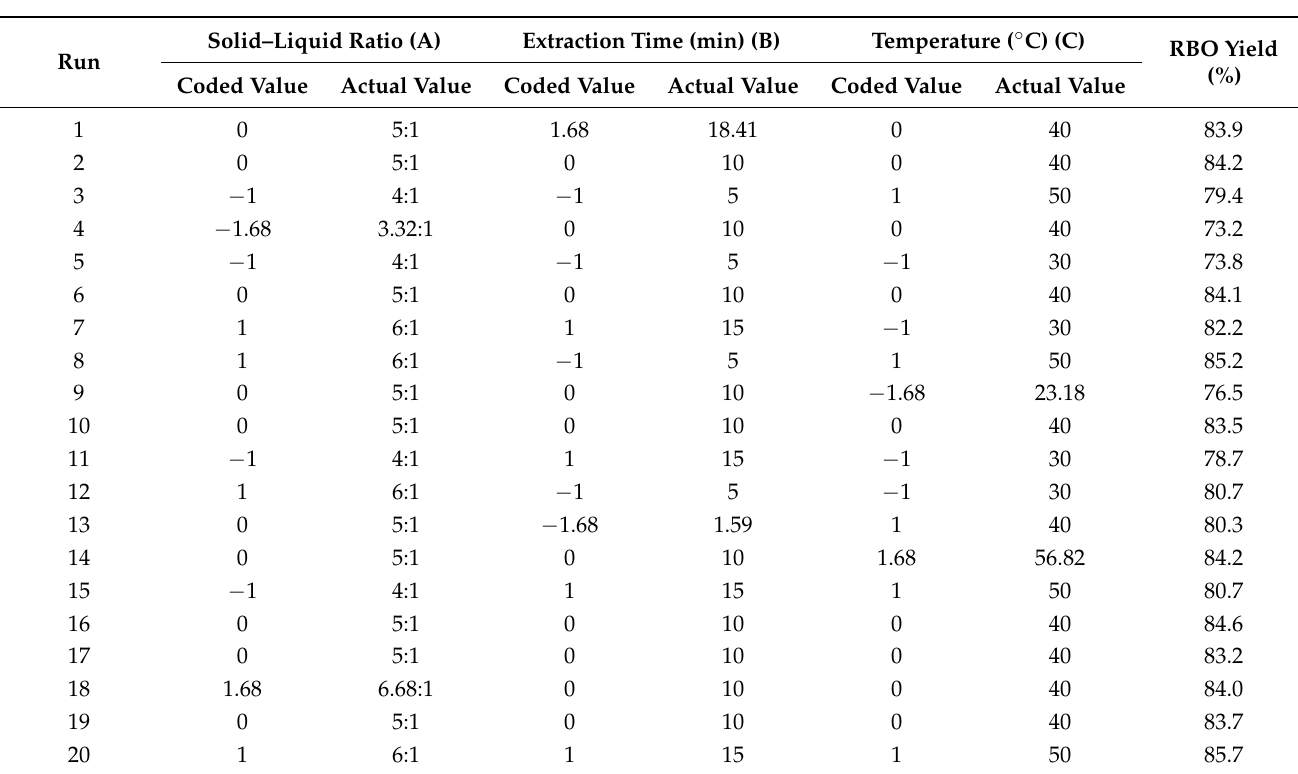
Table 1. Three-level central composite design with three independent variables and experimental results (yield of